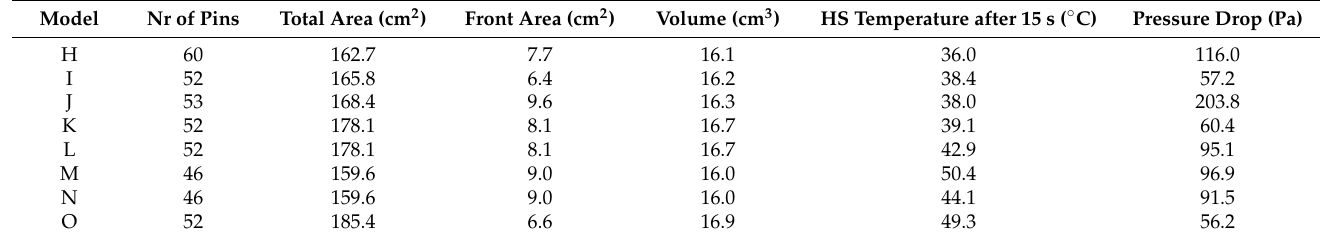
Table 8. Temperature and pressure drop for each pin heat sink model.